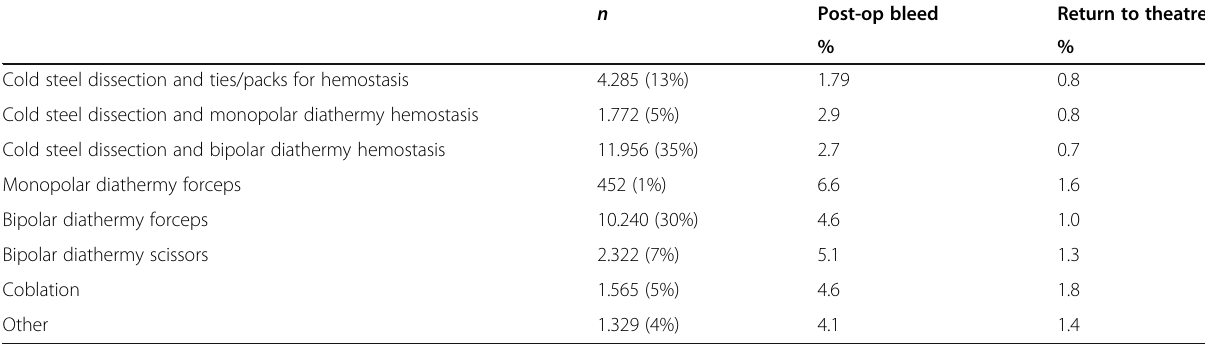
Table 1 NPTA rates of post-tonsillectomy bleeding by surgical technique